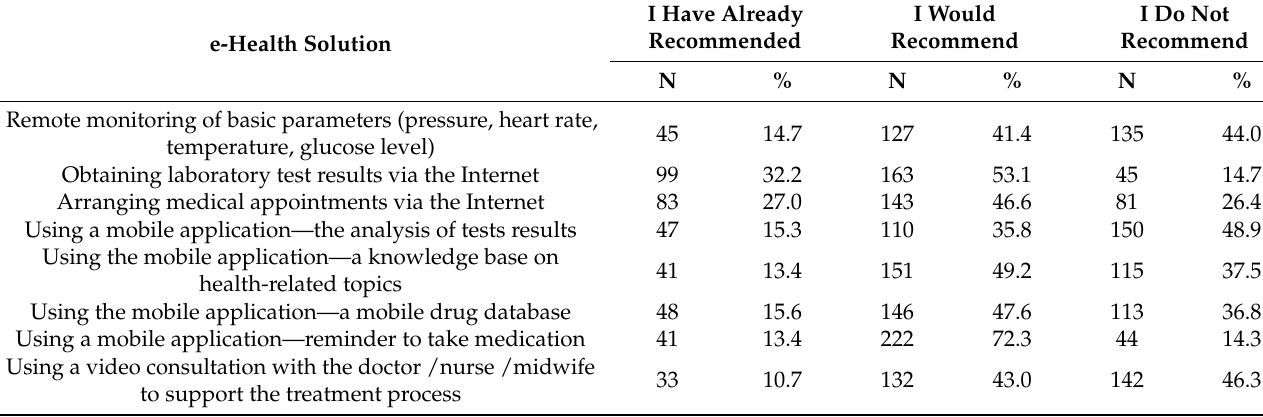
Table 7. Types of E-Health solutions recommended by